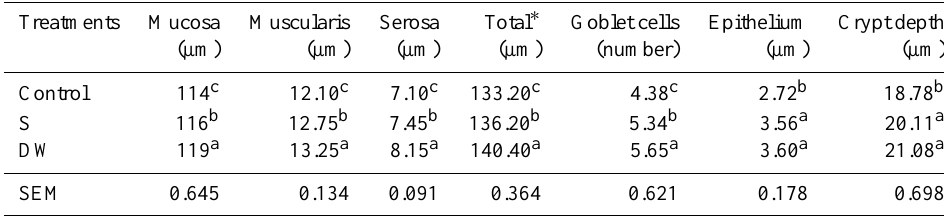
Table 7. The effect of sumac and whey powder diets on intestinal characteristics of female broiler chicks. Treatments Mucosa Muscularis Serosa Total ∗ Goblet cells Epithelium Crypt depth